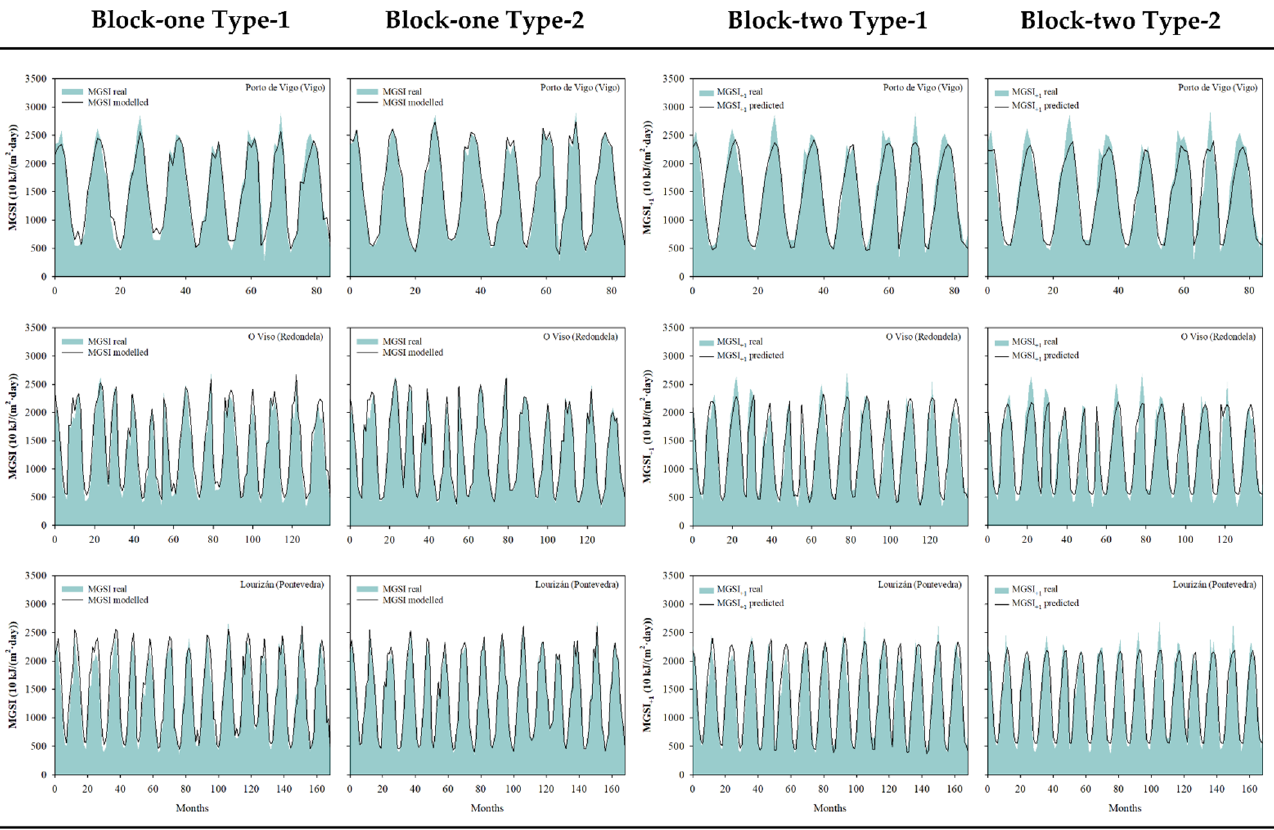
Figure 5. Real and modelled/predicted MGSI values for each measurement station according to the combination of the used variables to model the MGSI (Block-one Type-1 and Block-one Type-2) and to predict MGSI one month ahead (Block-two Type-1 and Block-two Type-2) for the stations: Q 6 —Porto de Vigo (Vigo), Q 7 —O Viso (Redondela) and Q 8 —Lourizán (Pontevedra)). The cyan shade is the real value of MGSI and the black line is the modelled/predicted MGSI value by each selected ANN model. Data from Puga-Gil (2022) [31].